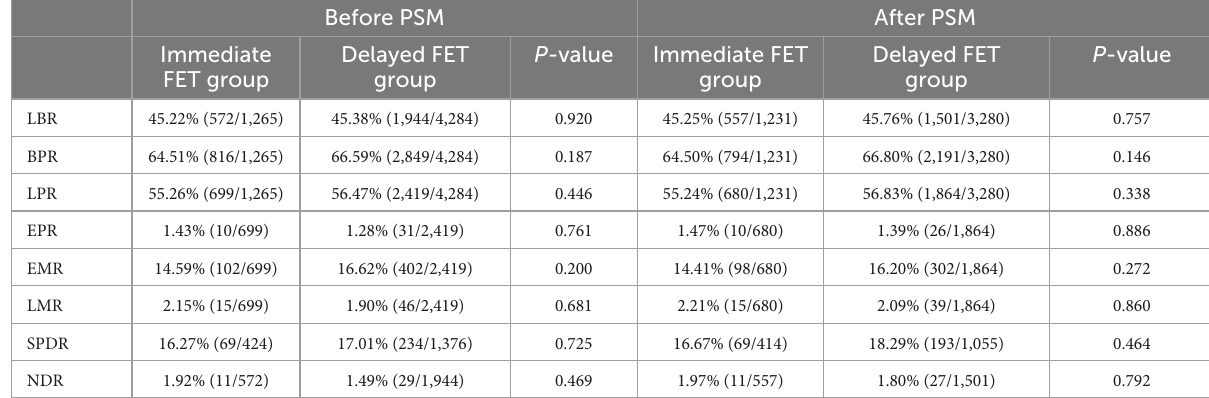
TABLE 2 Comparison of pregnancy outcomes between the immediate and delayed groups before and after PSM.